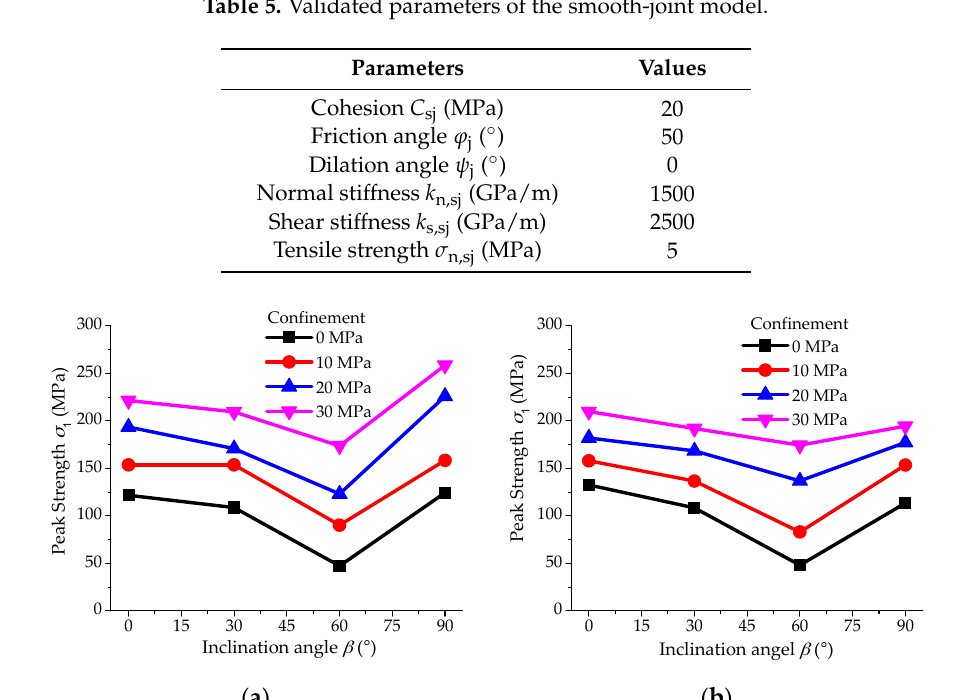
Table 5. Validated parameters of the smooth-joint model.